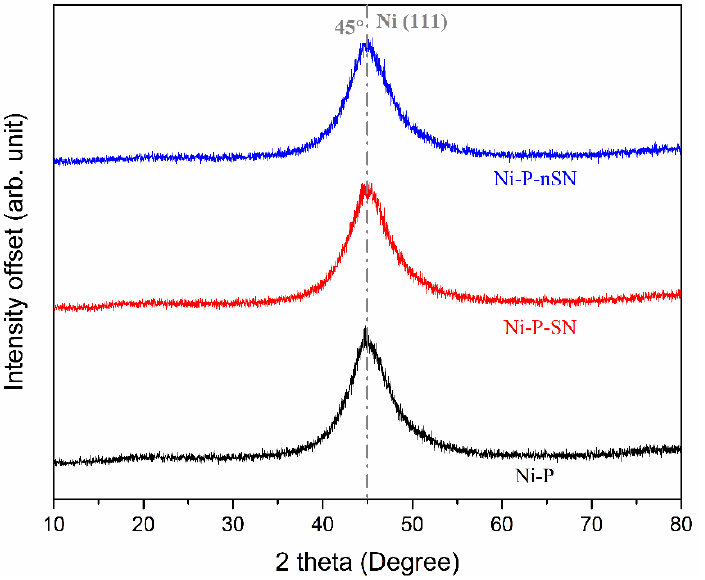
Figure 2. XRD pattern of as-coated Ni-P, Ni-P-SN, and Ni-P-nSN specimens. The peak located at ~45° of 2 theta axis in all the specimens belongs to the Ni (111)